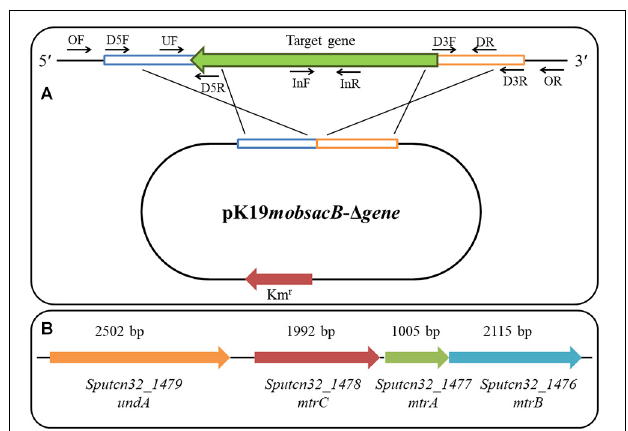
FIGURE 1 | The primer positions for target gene in-frame deletion (A) and genomic arrangement of mtrA, mtrB, mtrC , and undA in S. putrefaciens CN32 (B)